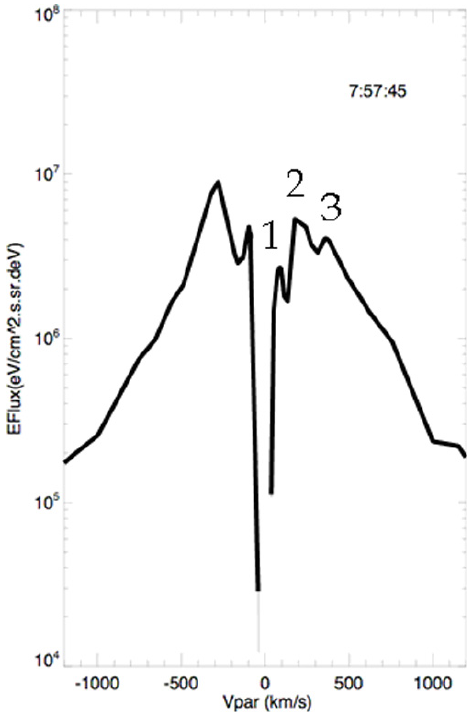
Fig. 12. Cut parallel to the magnetic field through the distribution function recorded by CIS-HIA on board SC3 at